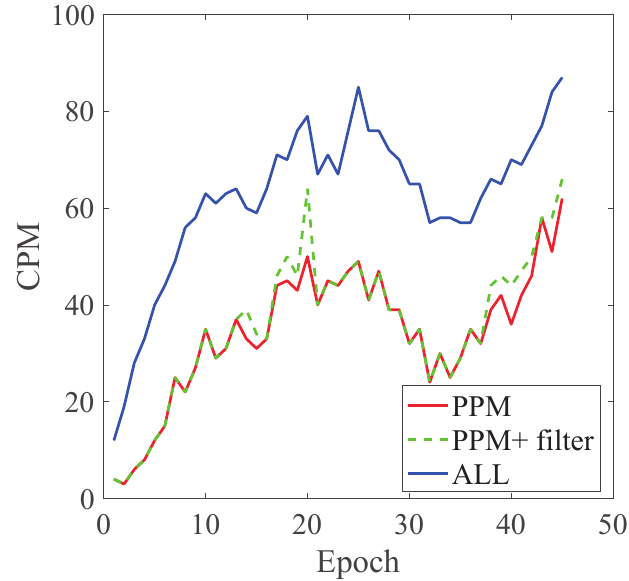
Figure 12. Result of